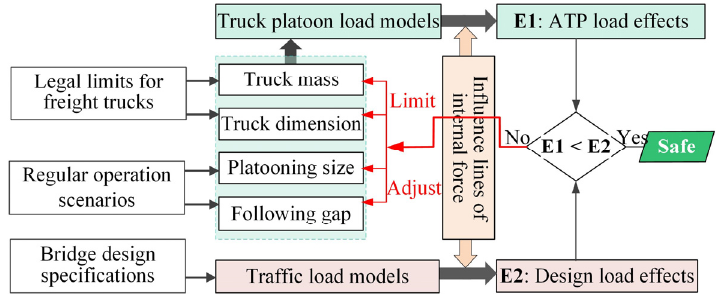
Figure 4. Assessment method of ATP-induced load effects.